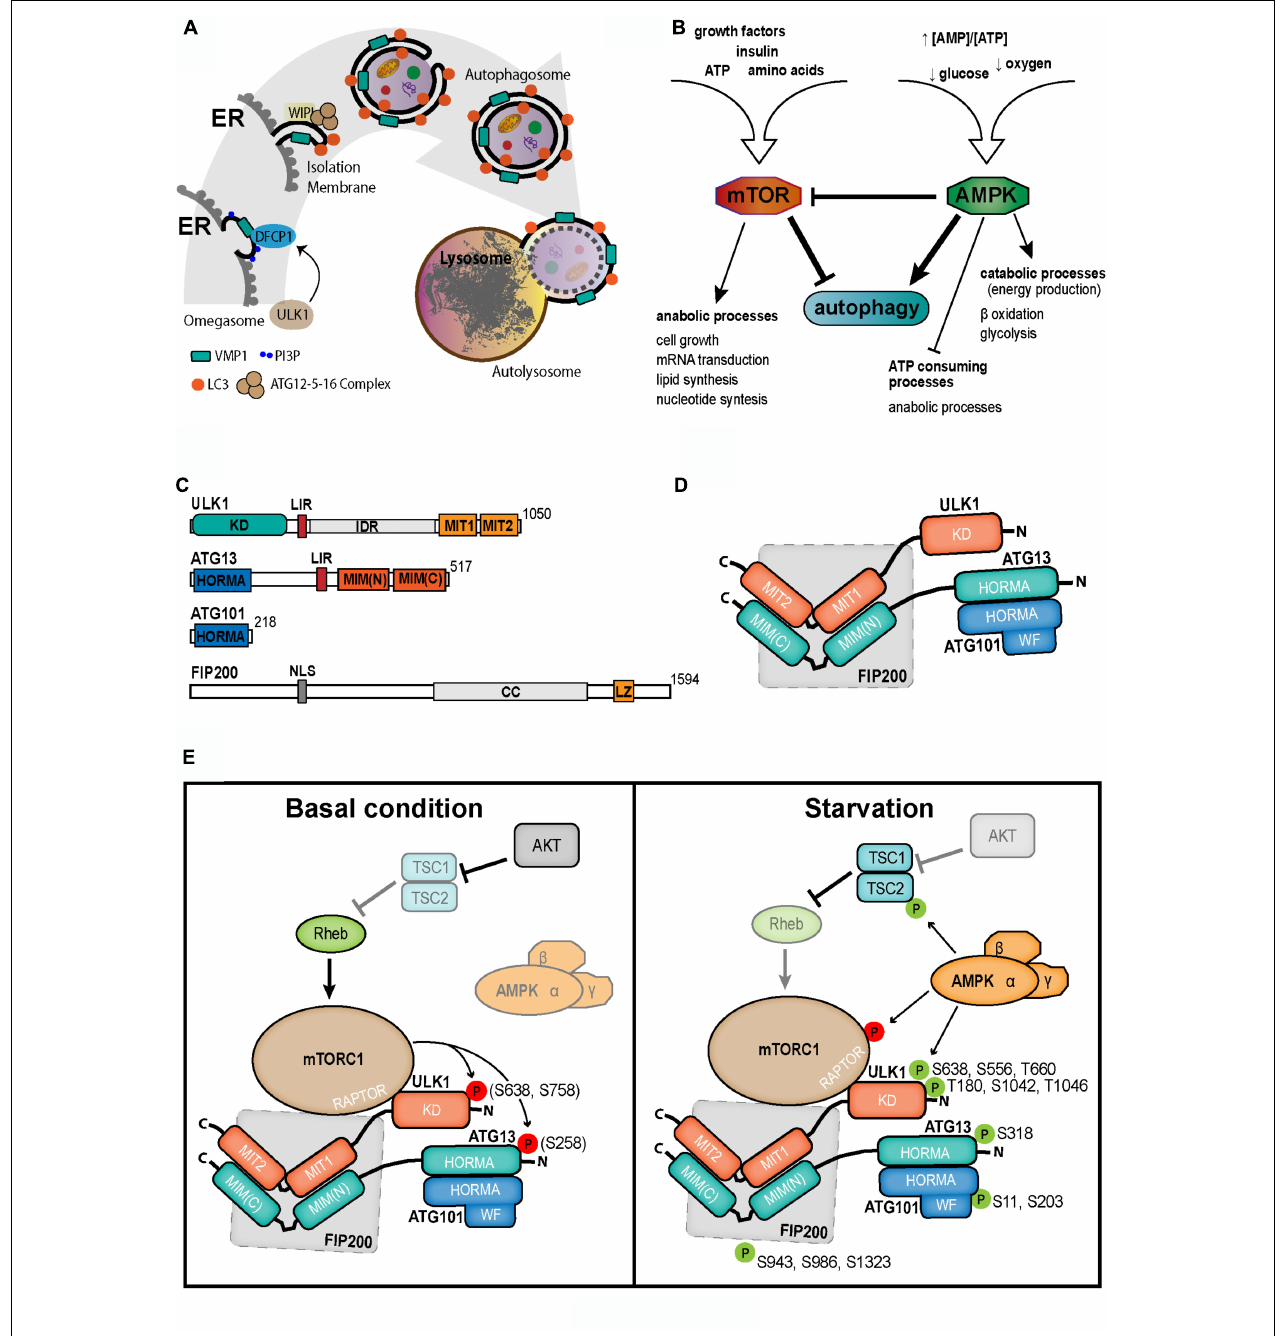
FIGURE 1 | (A) Schematic overview of autophagy. UKL1 activation leads to autophagosome biogenesis. On the ER surface, the transmembrane protein VMP1 recruits a PI3K complex. The consequent PI3P subdomain is recognized by DFCP1 on the omegasome structure. Then, in the isolation membrane, WIPI proteins recruit the ATG5-ATG12-ATG16 complex which in turn make possible the lipidation of LC3 on the membrane. The formation of autophagosome, a double membrane vesicle, allows the carrying of cargo to lysosome. Eventually, cargo is degraded in the resulted autophagolysosome. ER, endoplasmic reticulum; PI3K, phosphatidylinositol 3-kinase; PI3P, phosphatidylinositol (3,4,5) triphosphate (PI3P). (B) Diagram of interrelationship among the cellular energetic and metabolic regulators, mTOR and AMPK, and the autophagy. (C) Representative scheme of the ULK1 complex proteins. Upper right number in each scheme shows the length of the amino acid chain. Described domains are showed for each protein. (D) Possible structure and interrelationship among the ULK1 complex proteins, suggested from available data. KD, kinase domain; LIR, LC3-interacting region; IDR, intrinsically disordered region; MIT, microtubule interacting and trafficking domain; HORMA, HOP1, REV7, and MAD2 domain; MIM, MIT-interacting motif; NLS, nuclear localization signal; CC, coil-coil region; LZ, leucine zipper; WF, WF finger motif. (E) Regulation of the autophagy initiation complex ULK1 by mTOR and AMPK at basal (left) and starvation (right) conditions.